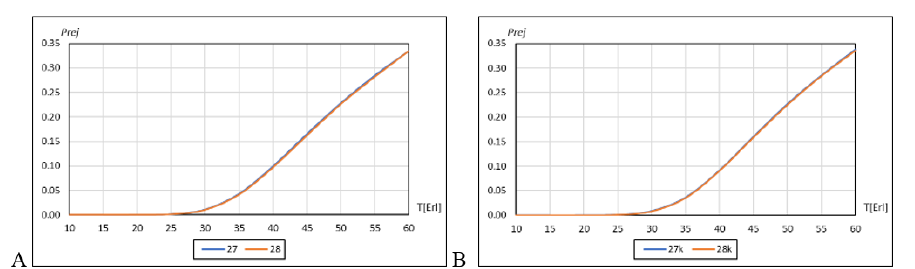
Figure 7. Results of simulations: ( A ) without any correction; ( B ) with correction.